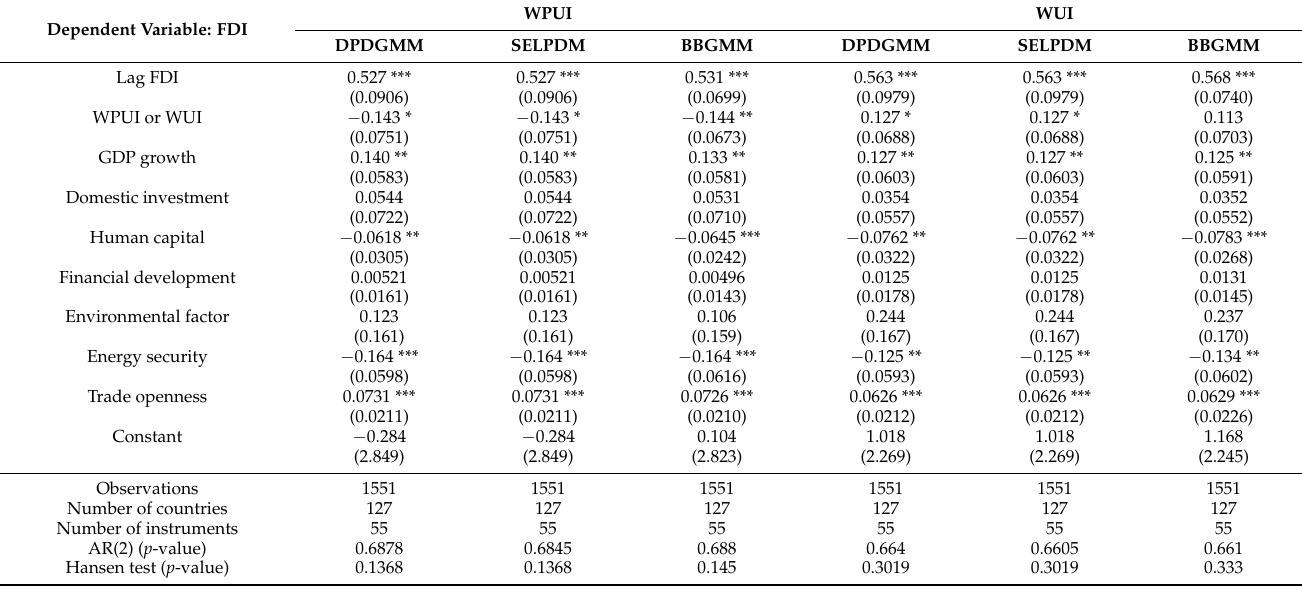
Table A4. Robustness